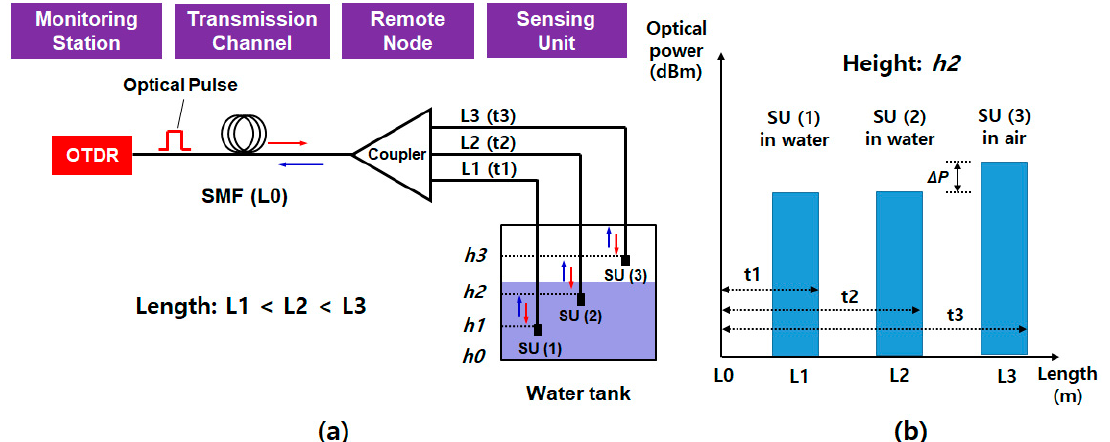
Figure 4. ( a ) Schematic diagram of the TDM-based water level monitoring system and ( b ) conceptual interrogation result at the water level of h 2. Adapted from Yoo et al. [36]. OTDR: optical time-domain reflectometer, SMF: single-mode fiber, SU: sensing unit, L 0: fiber length of SMF, L 1– L 3 ( t 1– t 3): fiber lengths (travelling times) according to the channels, and h 0– h 3: height of the water level where the SU are installed.